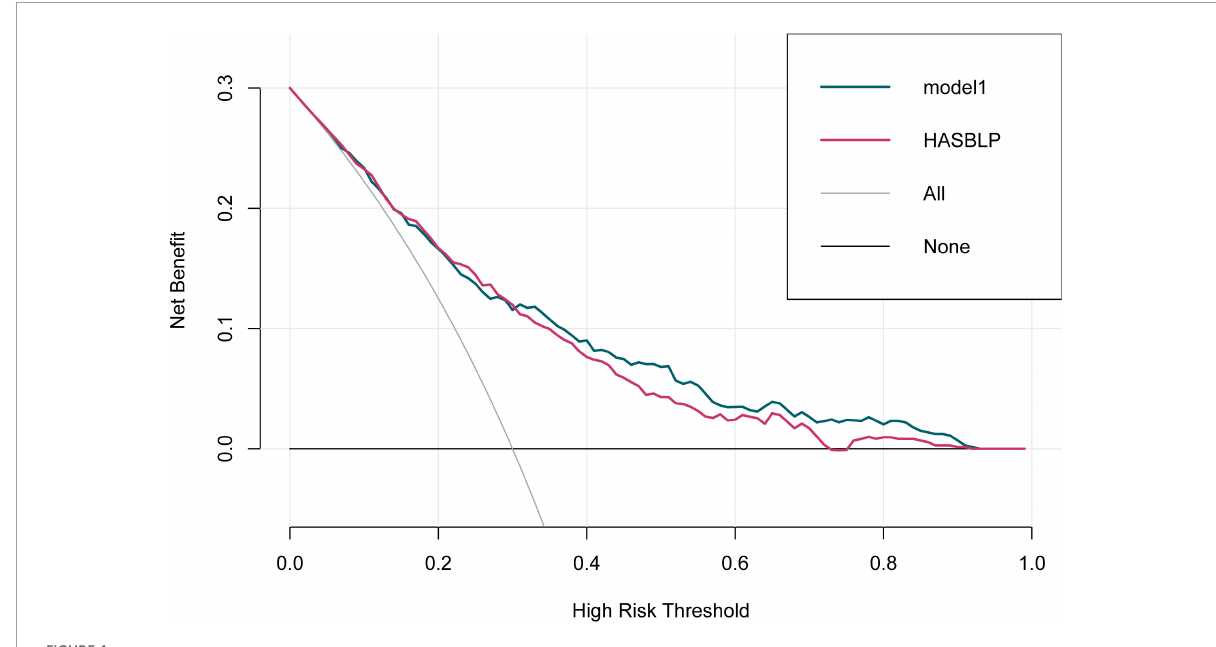
FIGURE4 Decision curve analysis curve of model